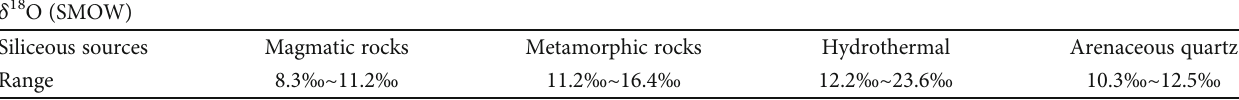
Table 1: Sources of siliceous minerals determined by δ 18 O value.